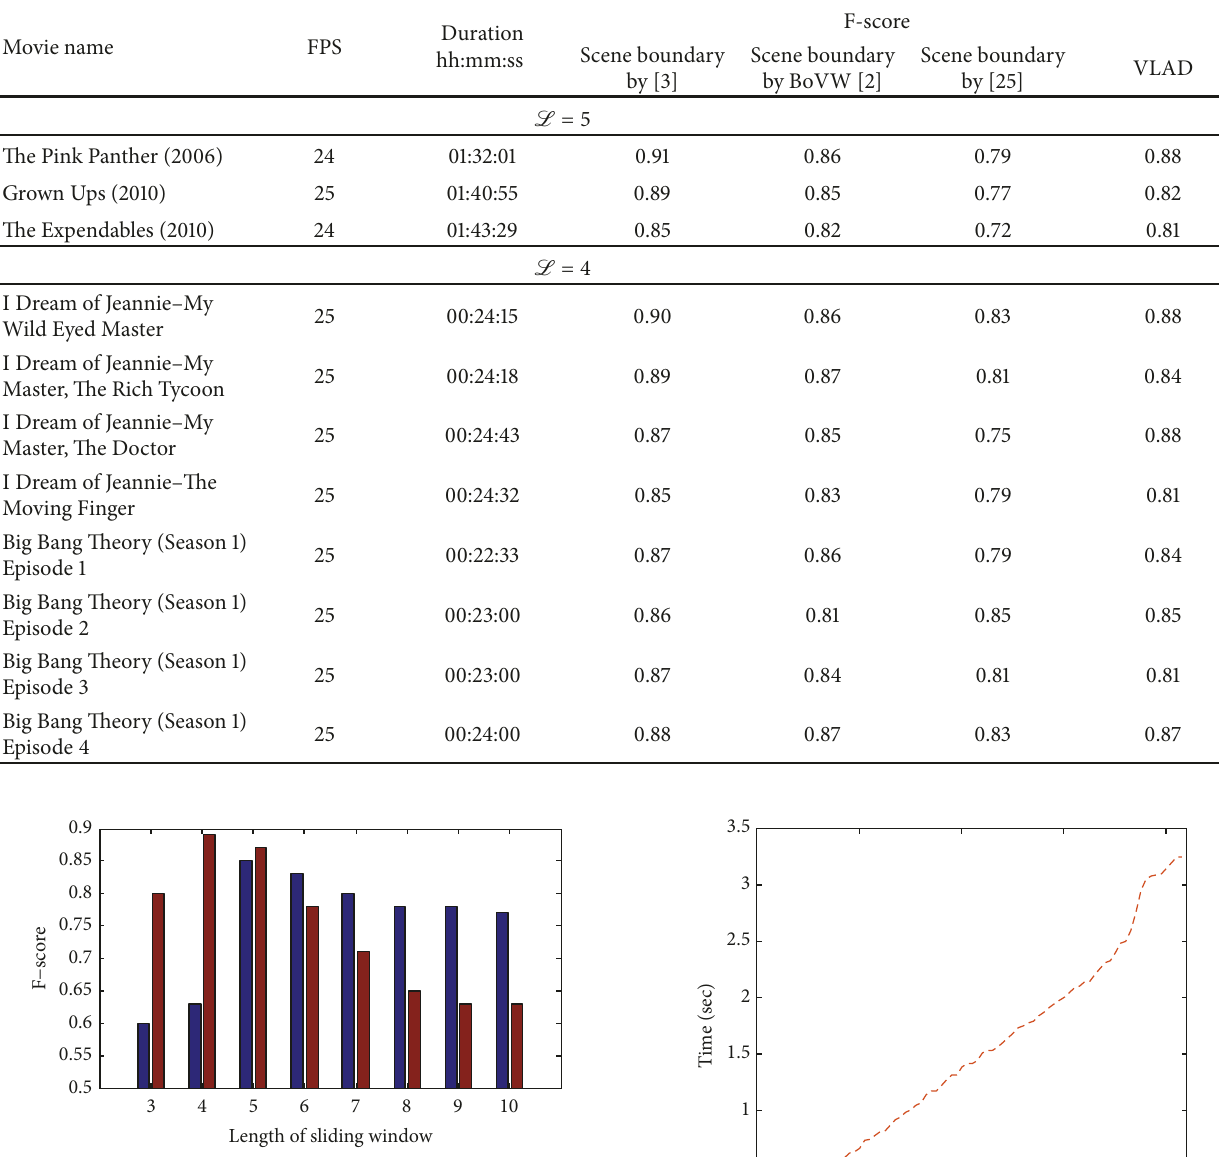
Table 1: Performance of BoVW and VLAD on cinematic and drama videos.